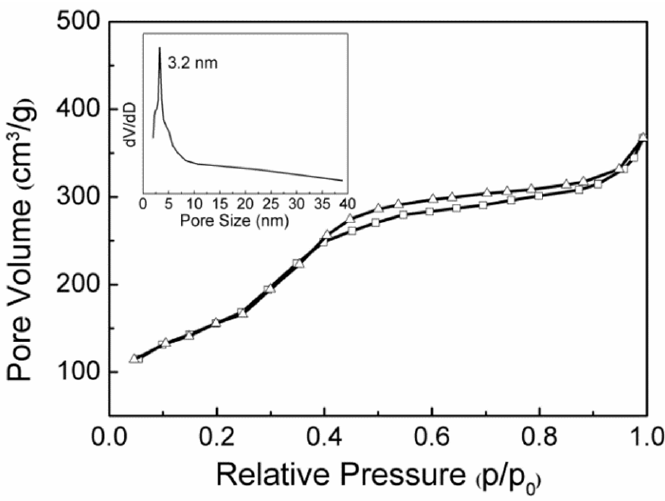
Figure 5. Nitrogen adsorption-desorption isotherms of ami-MSN, the smaller figure is the pore size distribution of ami-MSN.